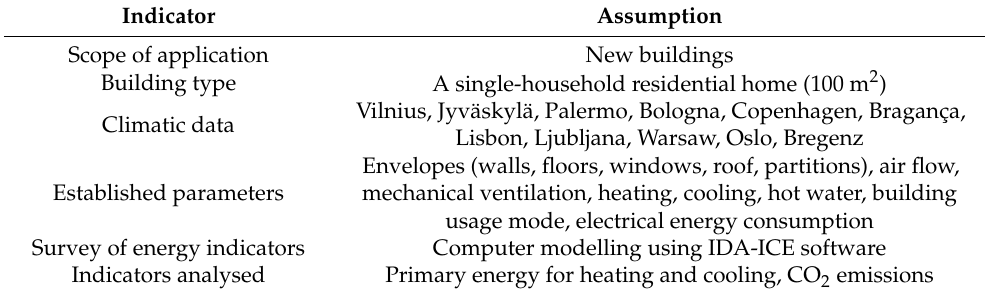
Table 8. Study assumptions.